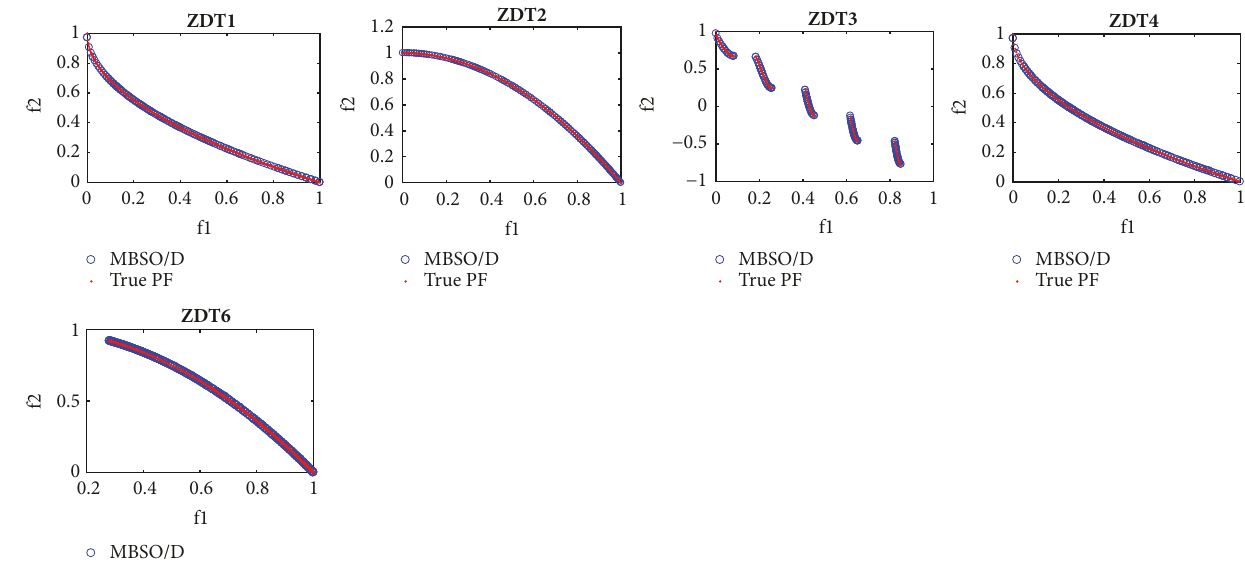
Figure 3: According to the median values of GD metric, nondominated solutions obtained by MBSO/D on five ZDT